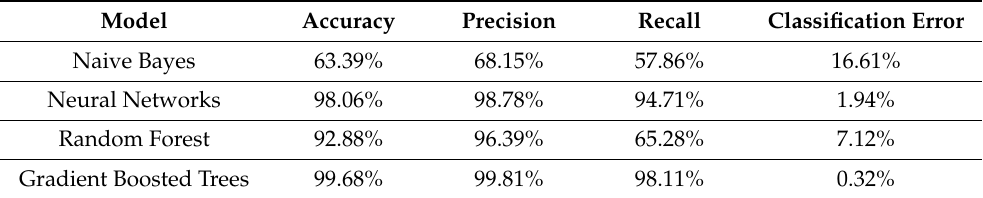
Table 7. Performance of the classifiers using a partial set of relevant features over the training